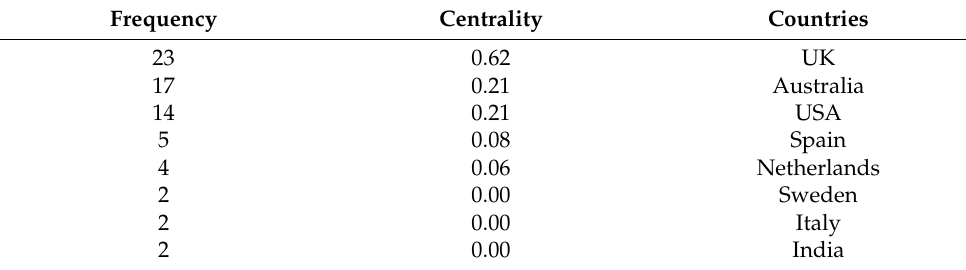
Table 2. Countries and their detailed information. Frequency